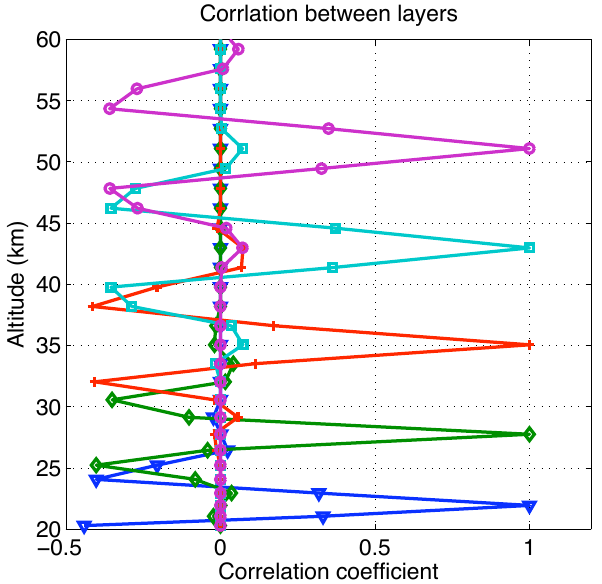
Fig. 8. Correlation of the retrieval error with neighbouring layers. Five selected altitudes (23km, 28km, 35km, 44km and 51km) are shown in different colours. Each of the lines correspond to correla- tions with the selected retrieved altitude (for which the correlation coefficient equals 1) and the errors layers above and below